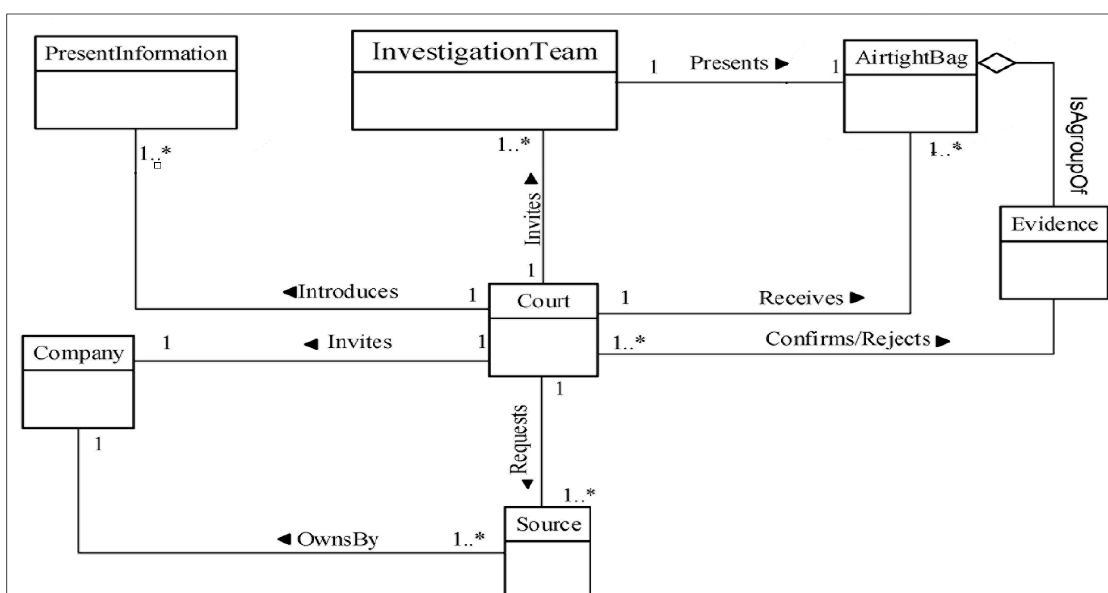
Figure 4. DBFIM documentation and presentation (Class 4).